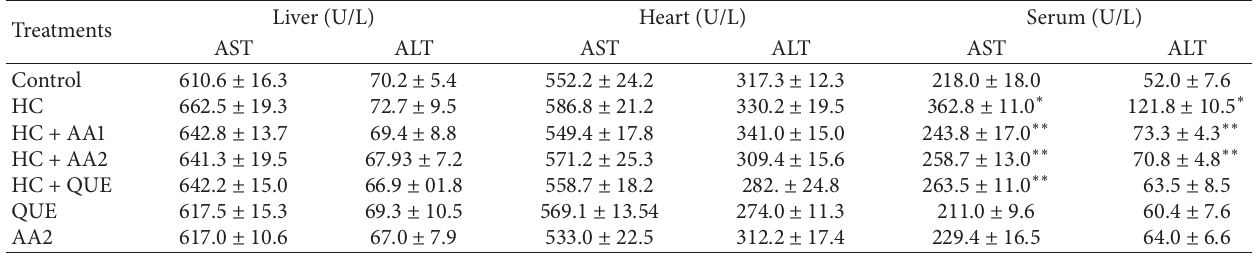
Table 5: Changes in the activities of serum, hepatic, and cardiac alanine and aspartate aminotransferases in hypercholesterolemic rats treated with methanol extract of Artocarpus altilis for nine weeks. Treatments